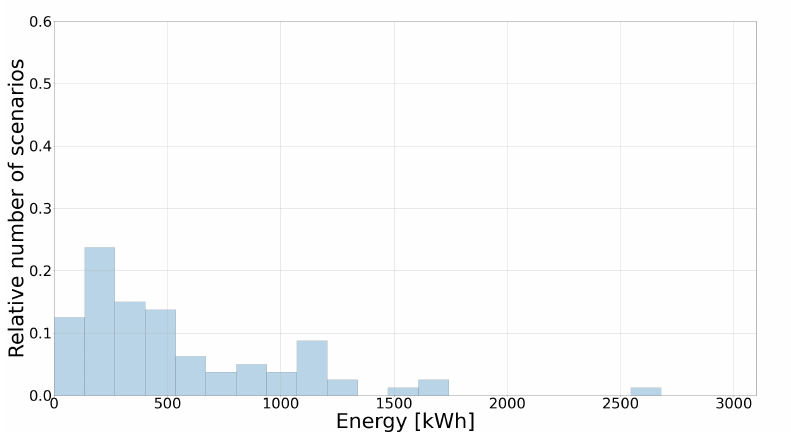
Figure 12. Histogram with PV generation time series shifted forwards by one hour.